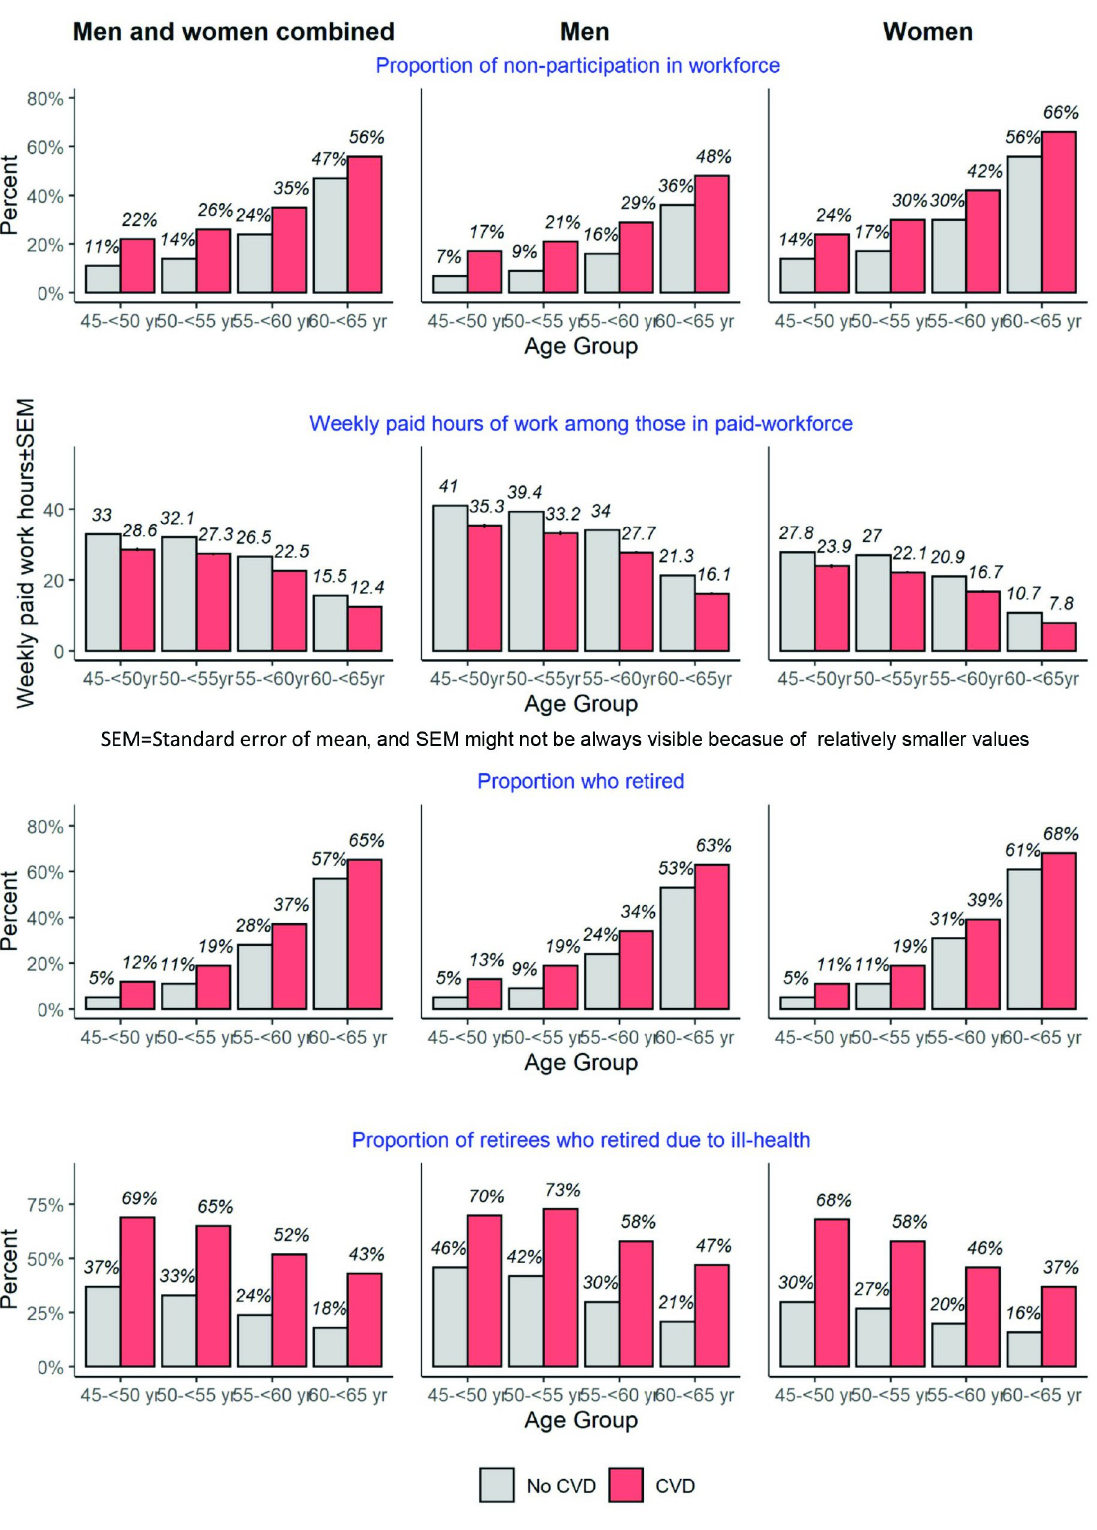
Fig 1. Workforce participation characteristics among study participants according to CVD status, sex and age-group.